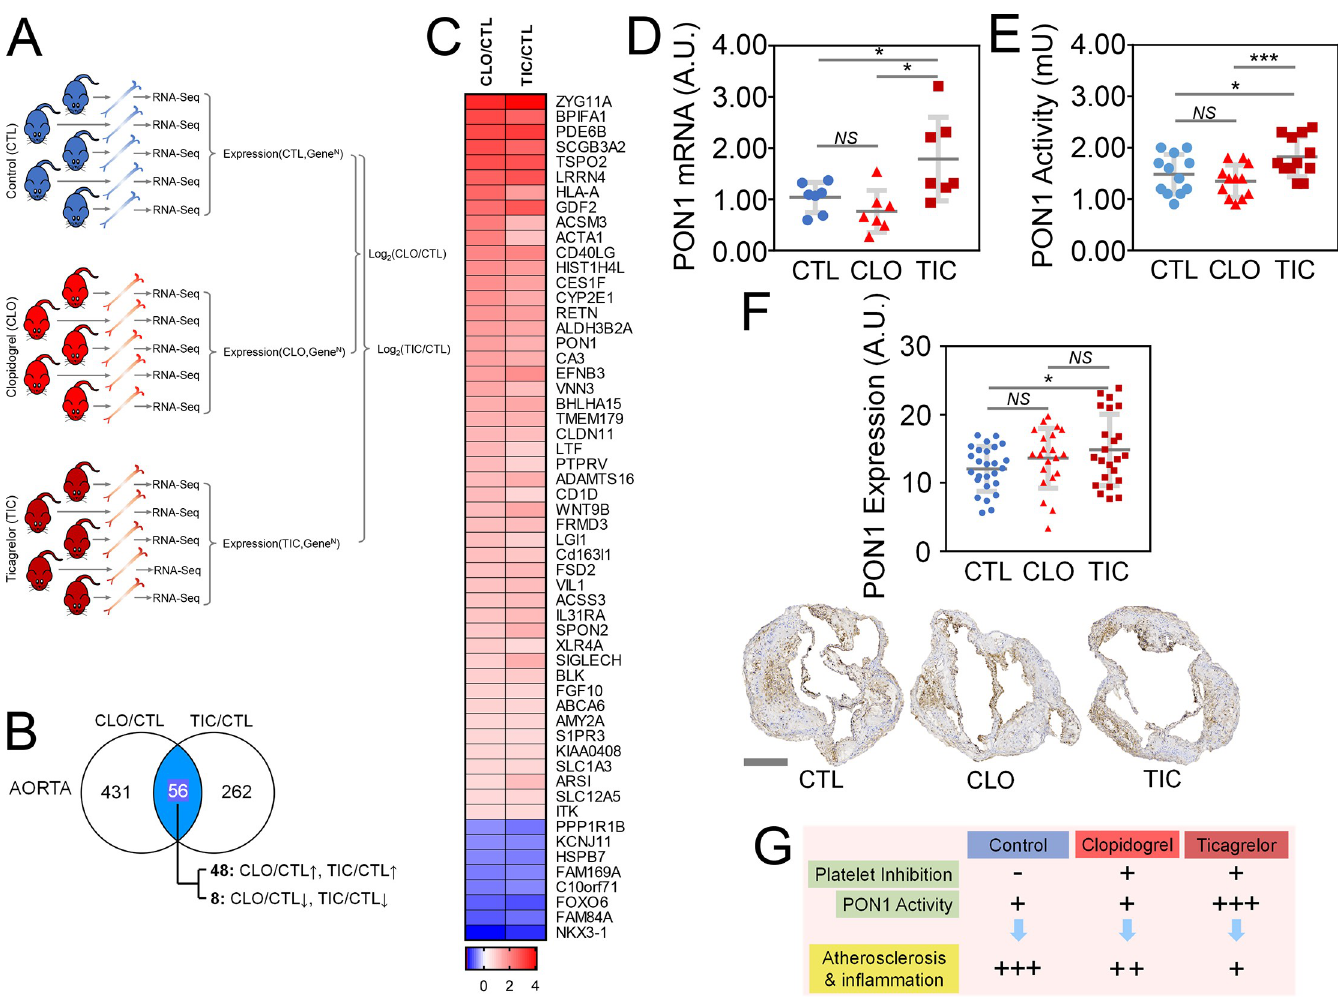
Fig 5. Ticagrelor treatment, but not clopidogrel treatment, induces the praroxonase-1 (PON1) message, increases tissue and serum PON1 protein, and mitigates atherosclerosis. Abbreviations: CTL, control; CLO, clopidogrel; TIC, ticagrelor; RNA-Seq, RNA sequencing using next generation sequencing; PON1, paraoxonase 1; A.U., arbitrary unit; N = 5 per group; Error bars, means ± SD, statistical analyses performed using one-way ANOVA test with Fisher’s multiple comparisons; NS , not statistically significant; � , P < 0.05; �� , P < 0.01 (See also S5 Fig). (A) Experimental protocol to explore the mechanism(s) by which TIC decreases atherosclerosis more than does CLO. (B) Comparison of differentially expressed genes of the CLO/CTL group with those of the TIC/CTL group. Fifty-six genes were concordantly and differentially expressed in both CLO/CTL and TIC/CTL groups, of which 48 genes were concordantly upregulated and 8 concordantly downregulated in both